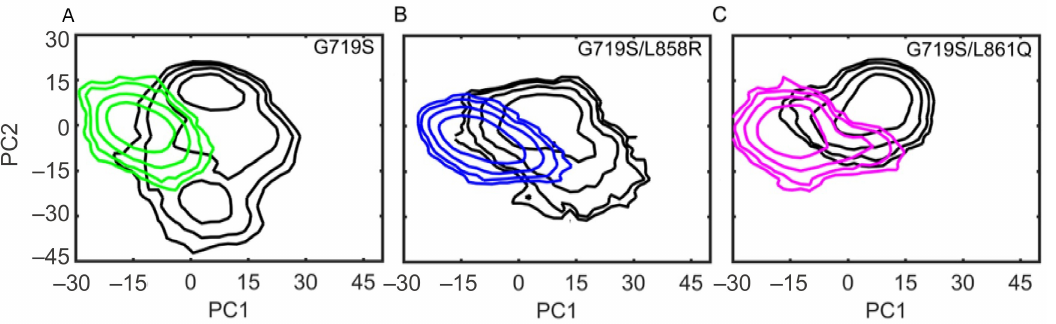
Figure 4. Conformational dynamics of EGFR in the APO and IRE-bound forms. The first two principal components (PCs) are shown in free energy surfaces. All APO forms are colored in black ( A – C ). Complex systems of G719S-IRE ( A ), G719S/L858R-IRE ( B ), and G719S/L861Q-IRE ( C ) are colored in green, blue, and magenta,